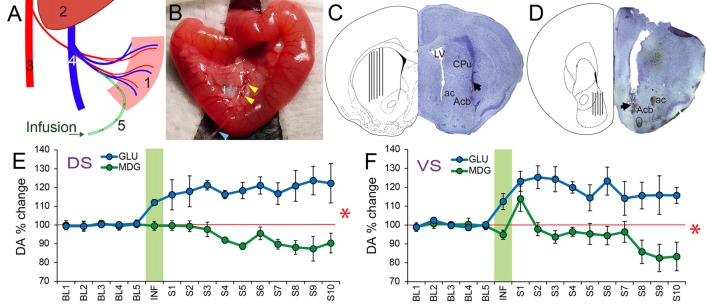
Extracellular levels of DA in Ventral and Dorsal Striatum increase significantly in response to portal infusions of glucose, but not of MDG. (A) Schematic representation of the portal catheterization. Legend: (1) Intestine; (2) Liver; (3) Abdominal Aorta; (4) Portal Vein; (5) Infusion catheter. (B) Portal catheter inserted into mesenteric vein. Yellow arrowheads indicate the fixation of the catheter; Blue arrowhead points to the catheter. (C) The figure shows a coronal section of the mouse brain through the dorsal striatum (caudate/putamen) region. On the right hemisphere is shown a representative Nissl-stained section revealing the tract associated with the tip of an inserted probe (dark arrow). On the left hemisphere is shown the corresponding region in a stereotaxic atlas (Paxinos and Franklin, 2001) containing a depiction of the spread of the actual probe positions. ac, anterior commissure; Acb, Nucleus accumbens of the ventral striatum; CPu, caudate/putamen of the dorsal striatum; LV, Lateral ventricle. (D) The figure shows a coronal section of the mouse brain through the Nucleus Accumbens of the ventral striatum. On the right hemisphere is shown a representative Nissl-stained section revealing the tract associated with the tip of an inserted probe (dark arrow). On the left hemisphere is shown the spread of the actual probe positions. ac, anterior commissure; Acb, Nucleus accumbens of the ventral striatum. (E) Mice implanted with portal intravenous catheters through which one of glucose or MDG was infused (see Table 1 for parameters). Microdialysis samples were then collected from dorsal striatum in freely behaving animals. Data correspond to timecourse of intestinal sugar effects on DA release (mean ± SEM) of percent DA change with respect to baseline (“BL”) pre-infusion period (Baseline = 100%, red horizontal trace). Vertical green area represents the onset and offset of infusions so that samples collected during this period are named “INF”. “S1–S10” = Samples post-infusion. All samples collected every 6 min. Portal infusions of GLU produced significant increases over baseline, whereas MDG infusions did not (N = 5; Two-way RM-ANOVA, stimulus × sample time effect F(15,60) = 7.8, *p < 0.001). (F) Portal GLU produced significantly greater DA release in ventral striatal compared to MDG (N = 5; Two-way RM-ANOVA, stimulus × sample time effect F(15,60) = 2.9, *p = 0.001). DA, Dopamine.